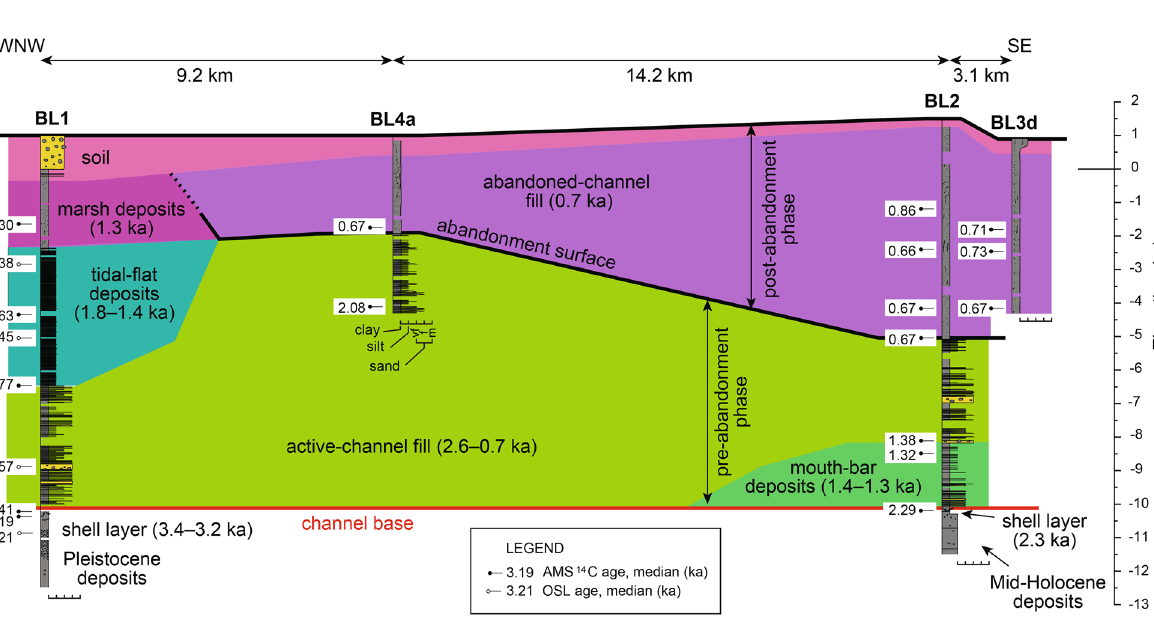
Figure 4. Panel reconstructed based on the four sediment cores showing a longitudinal section of the ancient Ba Lai channel. The section shows the stacking of different sedimentary facies of the pre-abandonment and post-abandonment